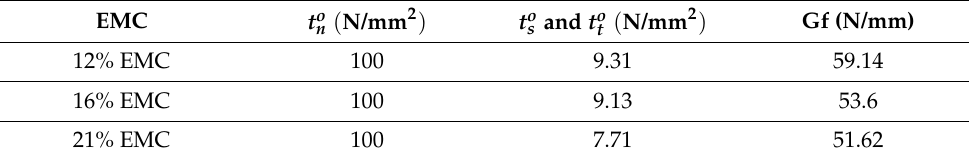
Table 19. 80 × 160 mm Glulam damage initiation and evolution values.